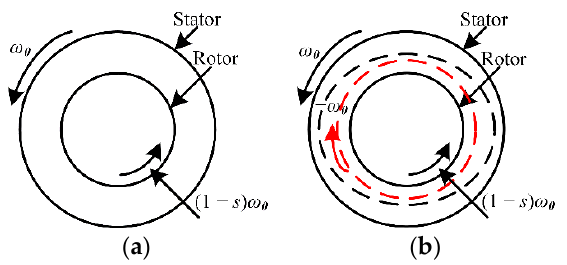
Figure 2. The rotating magnetic field distribution of stator and rotor before and after motor stator failure: ( a ) healthy motor. ( b ) Motor with stator interturn short-circuit fault.